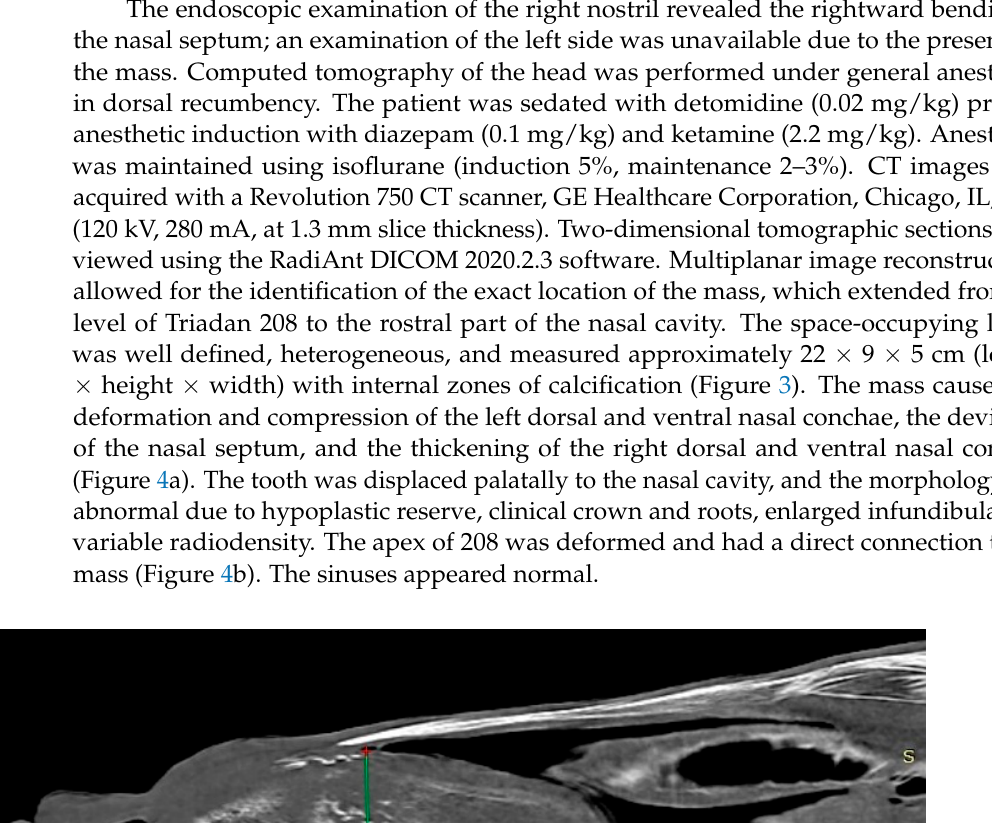
( a ) ( b ) Figure 4. ( a ) Transverse CT image at the level of Triadan 07 (bone algorithm, WW1500, WL 300), demonstrating a hetero- geneous mass obliterating the left nasal cavity (width × height—green lines). Note the rightward deviation of the nasal septum and thickened right dorsal and ventral nasal conchae (red arrows). Internal zones of calcification are present. ( b ) CT transverse plane at the level of Triadan 08 (bone algorithm, WW1500, WL 300). Note the relationship of the mass (white arrow) with the dental apex of Triadan 08 (red arrow). 2.3. Surgery Surgery was performed using the following steps: extraction of the deciduous teeth intra-orally, extraction of Triadan 208, and removal of the tumor. All procedures were performed in a standing position during the same anesthetic protocol. The horse was sedated using detomidine (0.02 mg/kg IV) and butorphanol (0.01 mg/kg IV), maintained with constant infusion rates for detomidine (0.02 mg/kg/h) and butorphanol (0.01 mg/kg/h) diluted in saline, delivered by an infusion pump. The dose was adjusted according to the horse’s behavior. Maxillary cheek teeth were anesthetized with a left infraorbital nerve block using 5 mL 2% lidocaine hydrochloride [24]. The left maxillary nerve was blocked caudally from the maxillary foramen with 20 mL of 2% lido- caine hydrochloride [25]. The horse was monitored with a vital sign monitor (ECG, pulse oximetry, capnography). The deciduous teeth 607 and 608 were removed intra-orally without any complications. Due to medial displacement and the oblique position of the